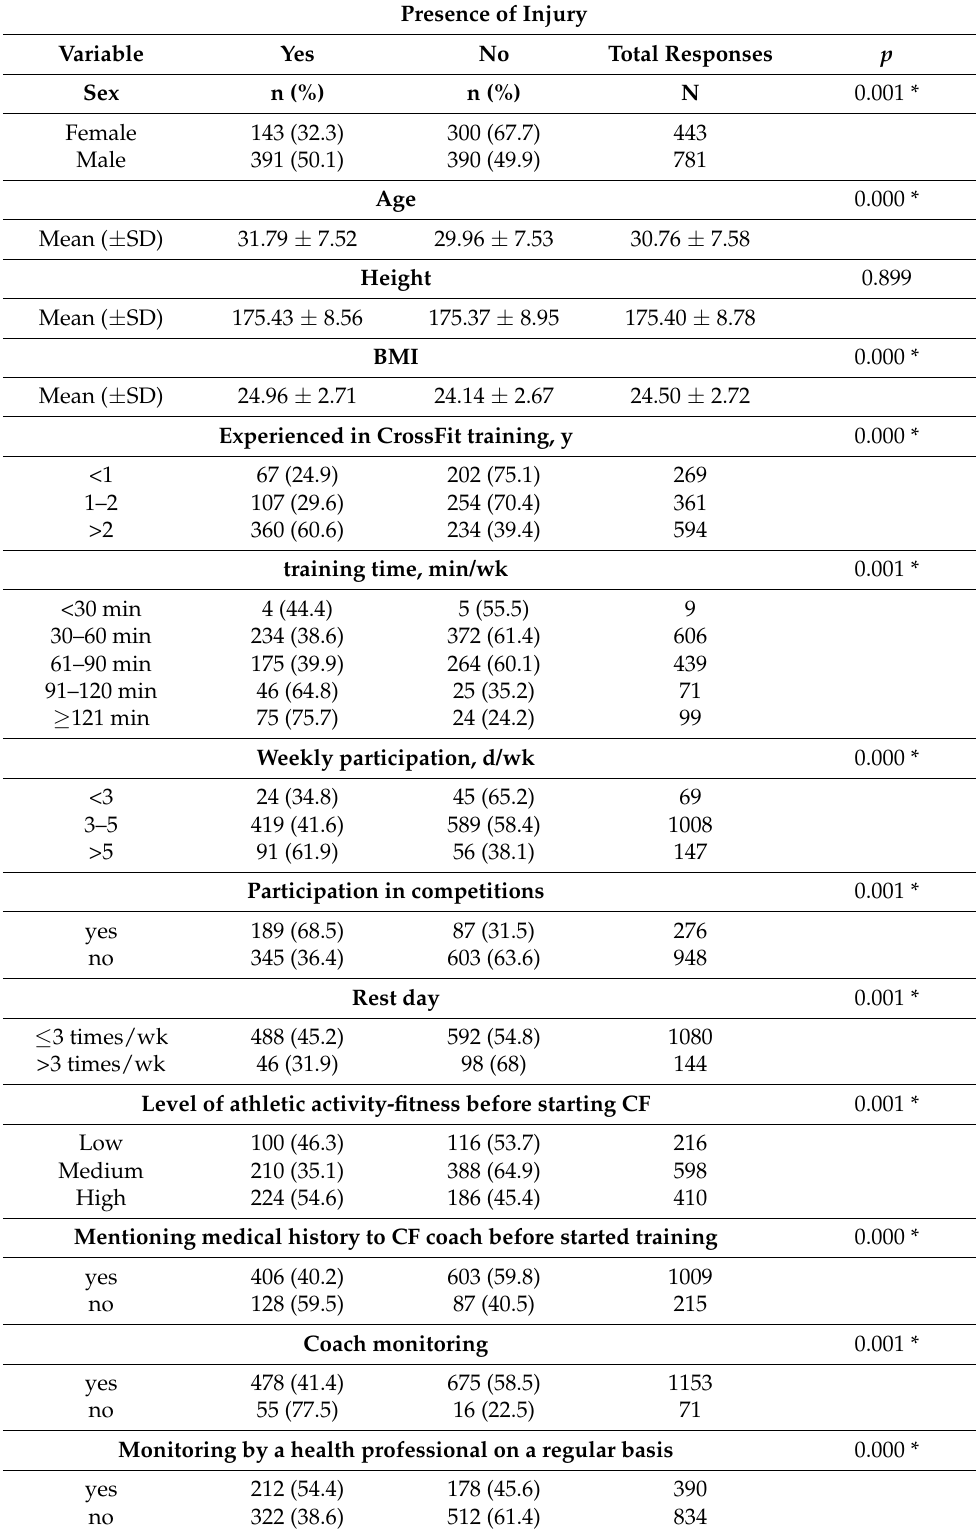
Table 4. Comparison of the profile characteristics of CF athletes with and without the presence of injuries.